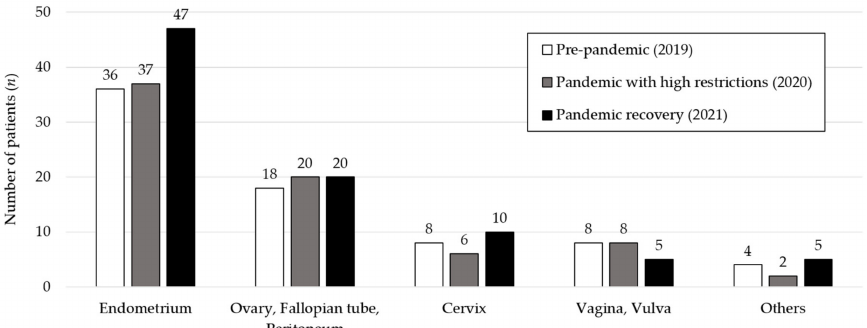
Figure 1. Number of patients diagnosed with gynecological cancer according to its location and pandemic period. Others: leiomyosarcoma, invasive hydatidiform mole, synchronous endometrial and ovarian